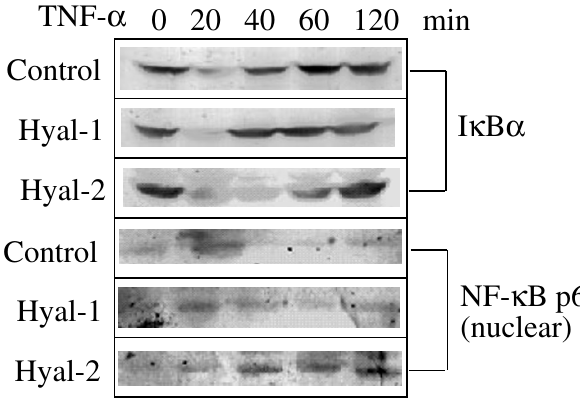
Figure 4 TNF mediates a prolonged period of I κ B α degradation and NF- κ B activation in L929 cells stably expressing GFP-Hyal-2.